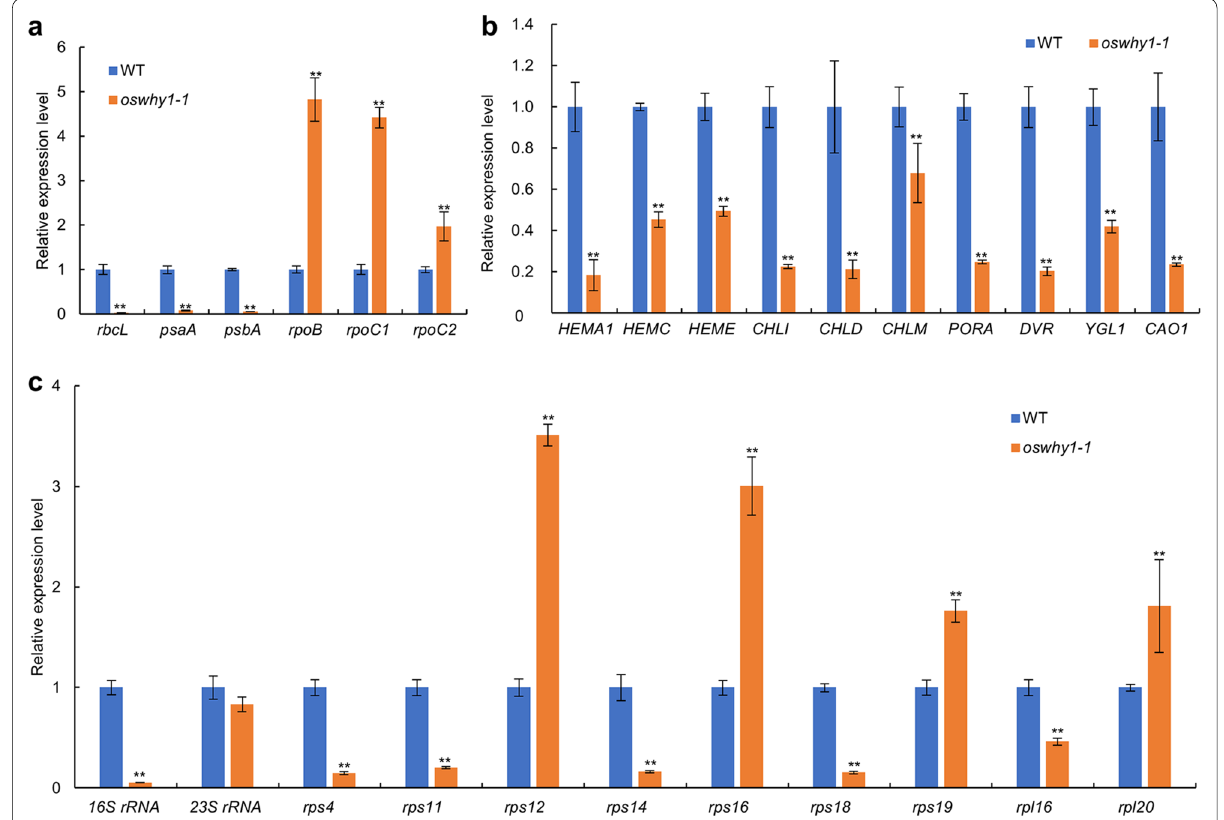
Fig. 7 Analysis of the relative transcript levels of genes related to chloroplast development, chlorophyll synthesis, and ribosome development. a The relative expression levels of plastid-encoded and nucleus-encoded chloroplast development-related genes. b Transcript analysis of chlorophyll synthesis-related genes. c The relative expression levels of genes associated with ribosome development. The relative expression level of each gene was normalized using UBQ5 as an internal control. The expression level of each gene in the WT was set to 1.0 and the other samples were calculated accordingly. Data are the mean SD (n 3). ** p < 0.01 (Student’s t ± =